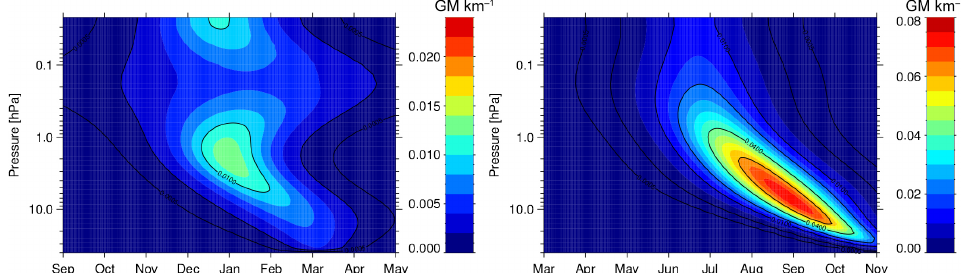
Figure 2. Temporal evolution of the vertical distribution of EPP-NO y differential amounts N d (z) during September–May in the NH (left) and March–November in the SH (right) as a result of the empirical model for a constant A p index of 10 (2002–2012 average). Note the different color scales for the NH and